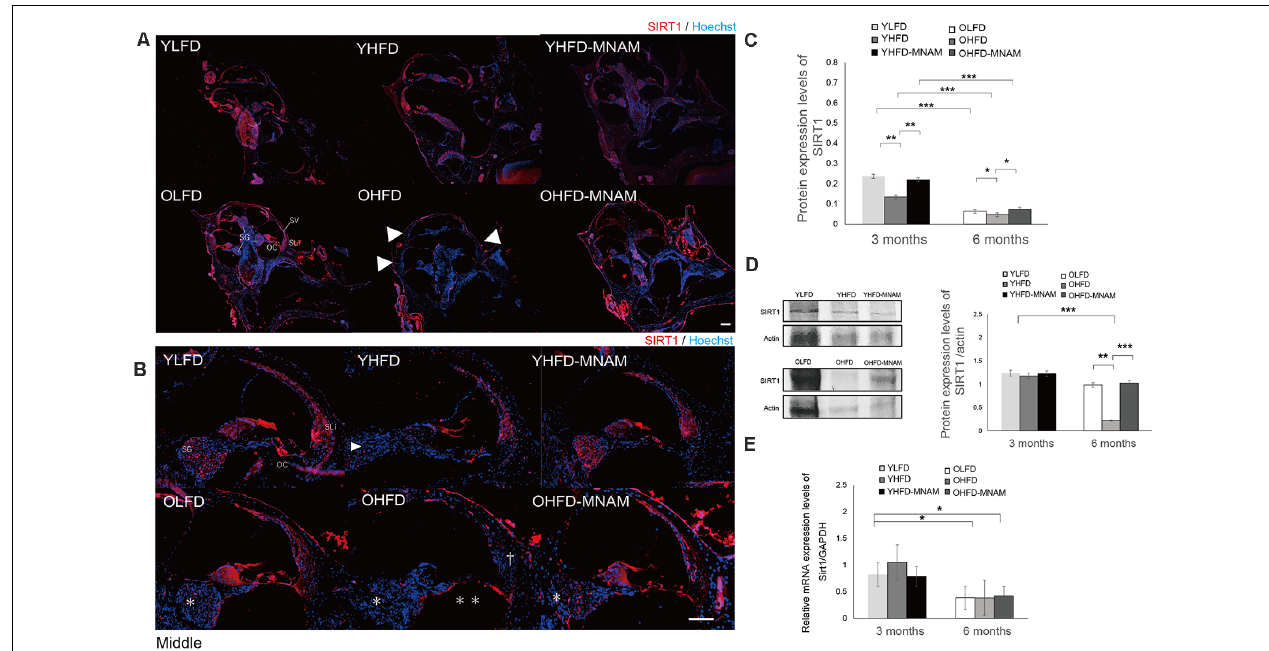
FIGURE 5 | SIRT1 expression in the cochlea: the age-related SIRT1 downregulation of expression observed in OHFD mice is absent in OHFD-MNAM mice. (A) SIRT1 staining (red) of the whole cochlea at 3 and 6 months after commencement of the experiment. SIRT1 is prominently localized in the OCs, SGCs, and type II and IV SLi cells in all turns within the cochlea. The arrowheads indicate a decrease in SIRT1 expression in the cochlea of the OHFD mice. (B) SIRT1 staining (red) of the middle turn of the cochlea at 3 and 6 months after commencement of the experiment. The arrowhead indicates a decrease in SIRT1 expression in the SGCs in the cochlea of the YHFD mice after experiment initiation. The asterisks indicate a decrease in SIRT1 expression in the SGCs in the cochlea of the OHFD mice after experiment initiation. The double asterisk indicates a decrease in SIRT1 expression in the OCs in the cochlea of the OHFD mice after experiment initiation. The dagger symbol indicates a decrease in SIRT1 expression in the SLi in the cochlea of the OHFD mice after experiment initiation. (C) The SIRT1 protein expression in the cochlea quantitatively analyzed using ELISA at 3 and 6 months after commencement of the experiment. The SIRT1 protein expression analyzed via ELISA decreased with aging ( p < 0.001 in each group). The YHFD and OHFD groups exhibited a decrease in the SIRT1 protein expression compared with the YLFD and OLFD groups ( p = 0.002 and p = 0.04). In the YHFD-MNAM and OHFD-MNAM, decrease in the SIRT1 protein expression was lower than that in the YHFD and OHFD groups ( p = 0.004 and p = 0.01; All groups, n = 5; * p < 0.05, ** p < 0.01, *** p < 0.001). (D) The SIRT1 protein expression in the cochlea quantitatively analyzed using WB analysis at 3 and 6 months after commencement of the experiment. β -actin expression was used as a reference. The OHFD mice exhibited a greater decrease in the SIRT1 protein expression compared to the OLFD mice ( p = 0.001). In the OHFD-MNAM group, decrease in the SIRT1 protein expression was less than that in the OHFD group ( p < 0.001; All groups, n = 5; ** p < 0.01, *** p < 0.001). (E) Sirt1 mRNA expression in the cochlea quantitatively analyzed using qRT-PCR at 3 and 6 months after commencement of the experiment. GAPDH expression was used as a reference. Sirt1 mRNA expression analyzed via ELISA decreased with aging ( p = 0.03 in the YLFD and OLFD, p = 0.02 in the YHFD and OHFD, p = 0.04 in the YHFD-MNAM and OHFD-MNAM). The YHFD and OHFD mice did not exhibit a decrease in Sirt1 mRNA expression compared with the YLFD and OLFD groups ( p = 0.14 and p = 0.49). In the YHFD-MNAM and OHFD-MNAM groups, there were no decreases in Sirt1 mRNA expression compared with those in the YHFD and OHFD groups ( p = 0.11 and p = 0.45; Bars: 100 µ m; Sirt1 , Sirtuin 1; YLFD, low-fat diet-fed 3-month-old mice; OLFD, low-fat diet-fed 6-month-old mice; YHFD, high-fat diet-fed 3-month-old mice; OHFD, high-fat diet-fed 6-month-old mice; YHFD-MNAM, high-fat diet plus 1% N 1 -methylnicotinamide-fed 3-month-old mice; OHFD-MNAM, high-fat diet plus 1% N 1 -methylnicotinamide-fed 6-month-old mice; OCs, the organ of Corti; SGCs, spiral ganglion cells; SLi, spiral ligament; SV, stria vascularis; ELISA, enzyme-linked immunosorbent assay; GAPDH, glyceraldehyde-3-phosphate dehydrogenase; WB, western blotting; mRNA, messenger ribose nucleic acid; qRT-PCR, quantitative reverse transcription-polymerase chain